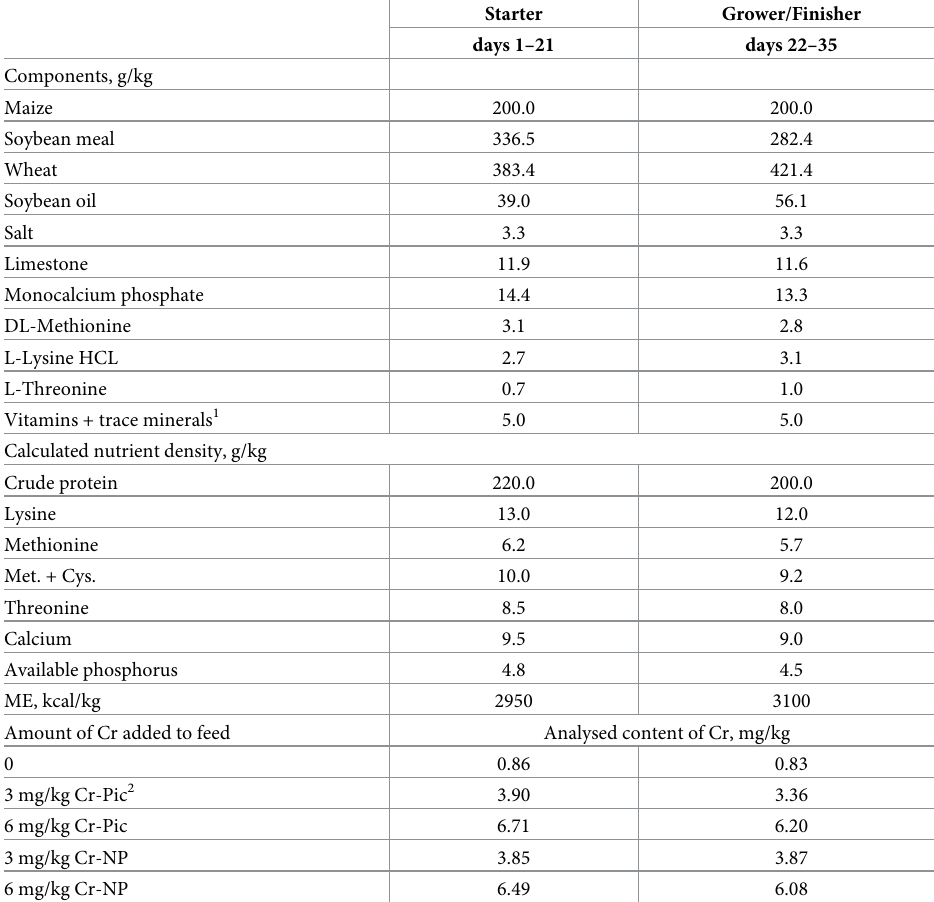
Table 1. Composition and nutrient density of